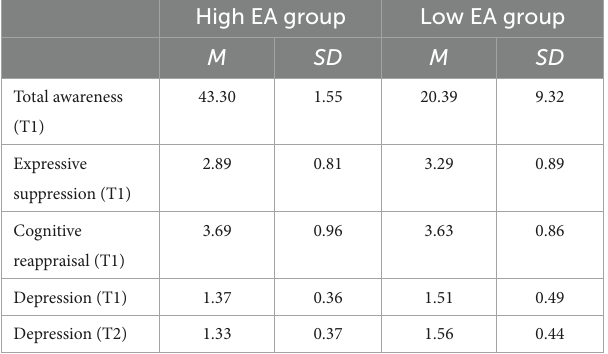
TABLE 2 The mean and standard deviation of the main study variables.